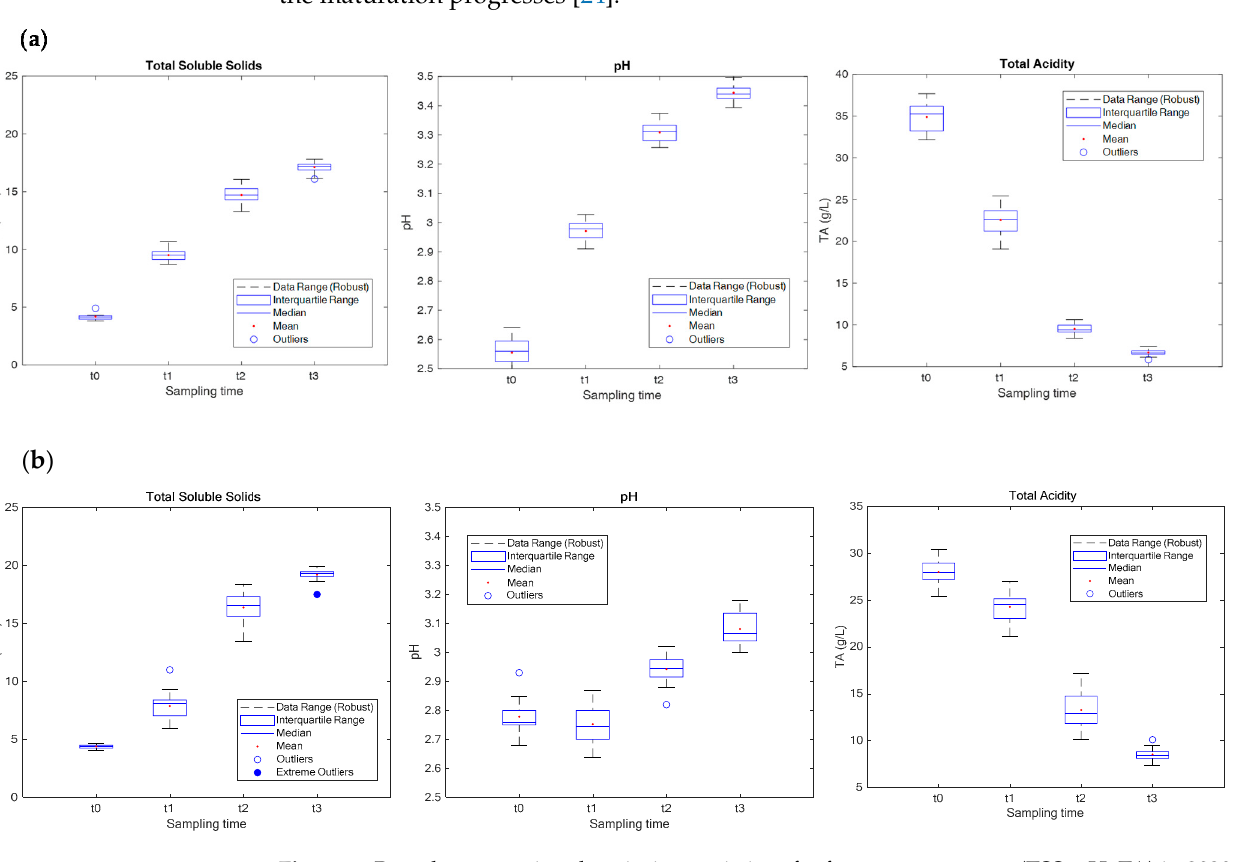
Figure 2. Box plots reporting descriptive statistics of reference parameters (TSS, pH, TA) in 2020 ( a ) and 2021 ( b ).